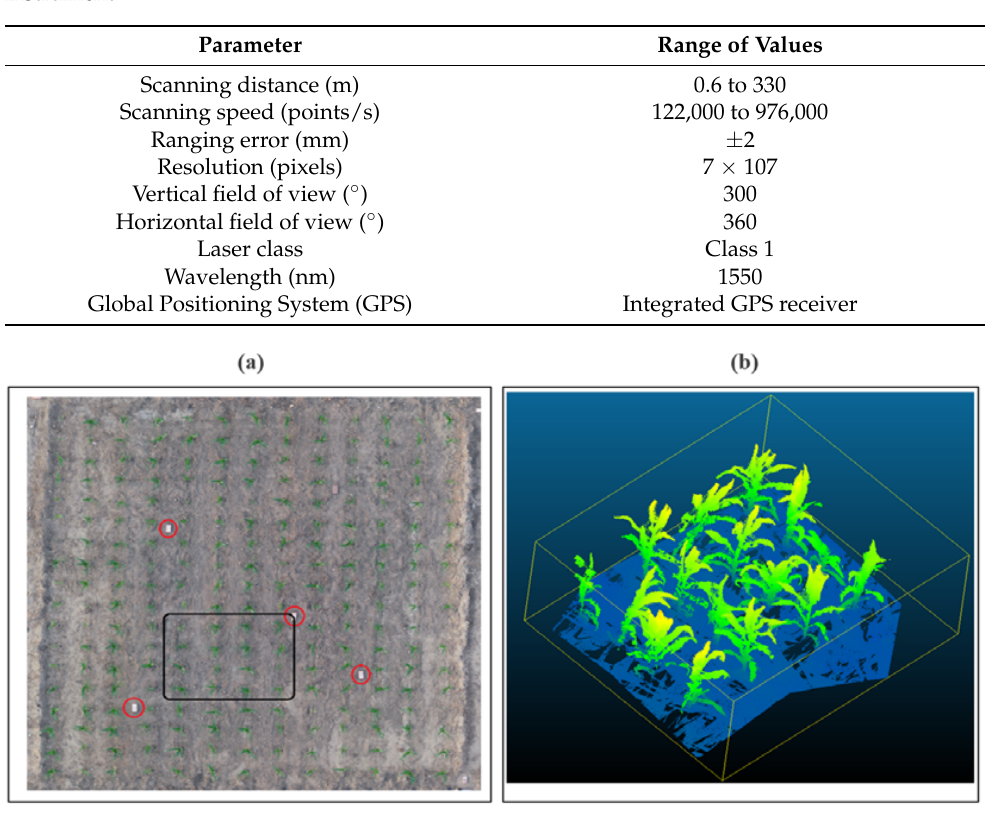
Figure 1. ( a ) study area and the registration points, ( b ) the point clouds of the 16 maize plants. The study site is located in Zhangjiakou, Hebei, China (latitude 40 ◦ 21 (cid:48) 00.9 (cid:48)(cid:48) N, Table 1. The parameters of the FARO Focus3D x330 LiDAR (Light Detection and Ranging) surveying instrument.